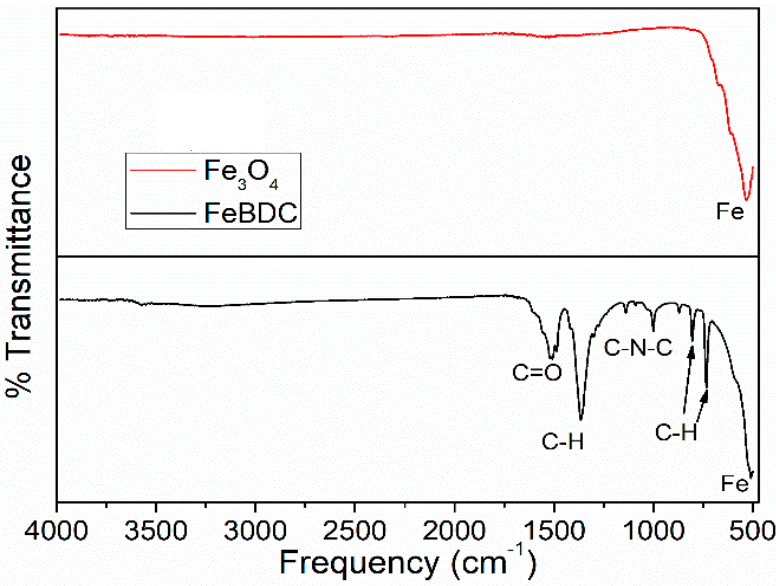
Figure 5. Fourier Transform Infra Red (FTIR) spectra of FeBDC and Fe 3 O 4 .